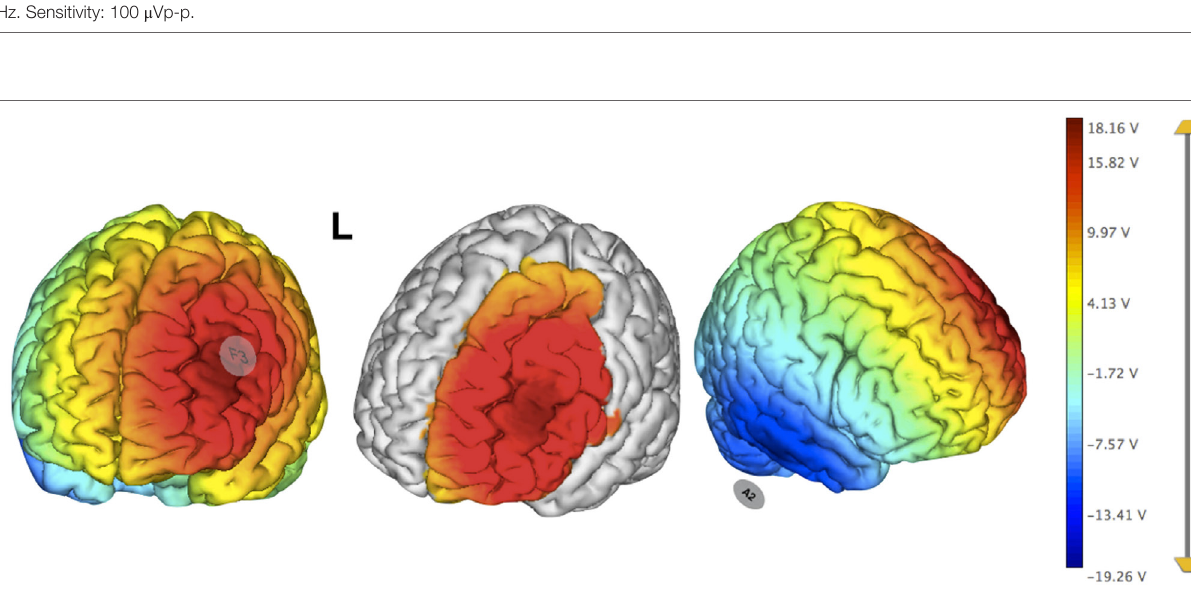
FIgURe 3 | Pre-treatment planning electrical field visualization of cathodal transcranial direct current stimulation protocol over F3 using 2 mA. Anode in contralateral mastoid (A2). Neuroelectrics Instrument Controller software © , Enobio 8. Barcelona, Spain. Abbreviations: R, right; L, left.